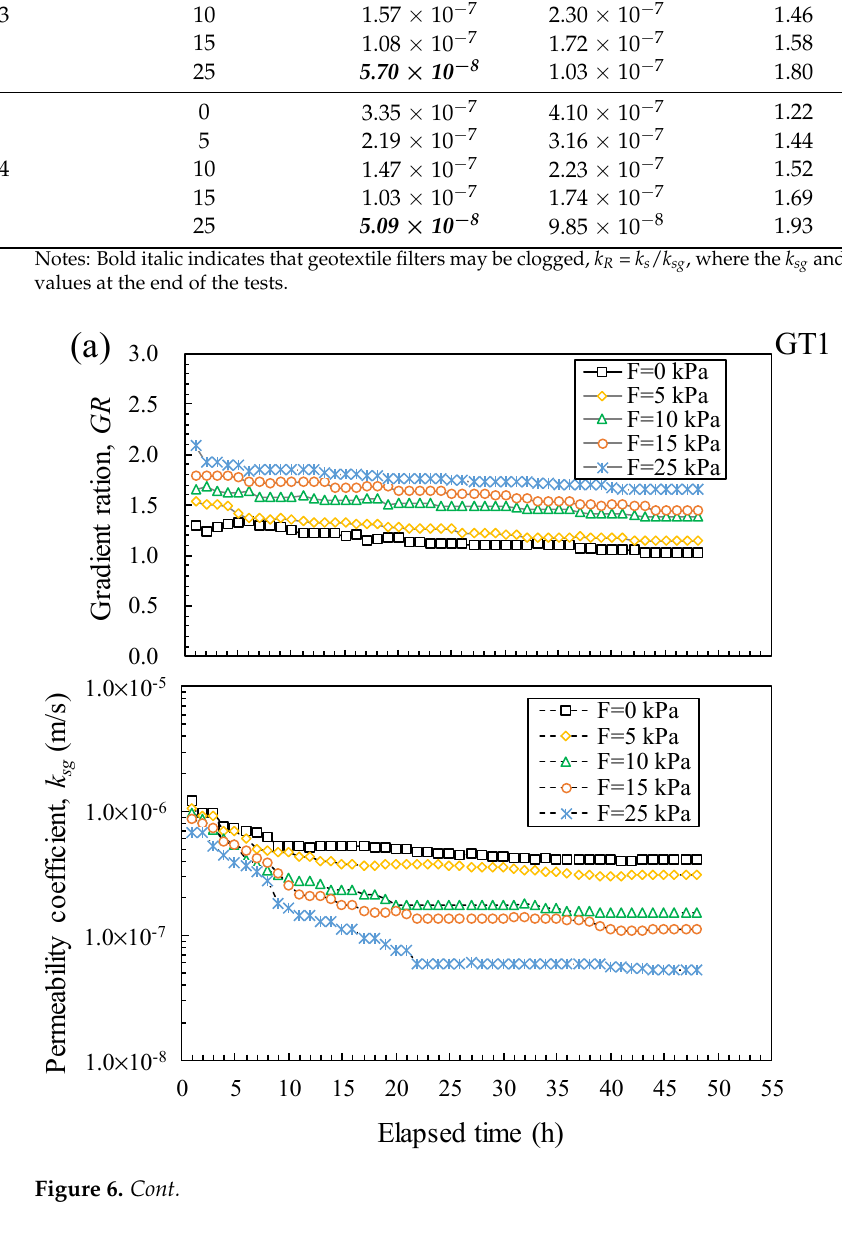
Table 8. Summary of the gradient ratio test results at 48 h performed on the silt–geotextile combination. Soil Geotextile Normal Stress (kPa) k sg (m/s) k s (m/s) k R GR